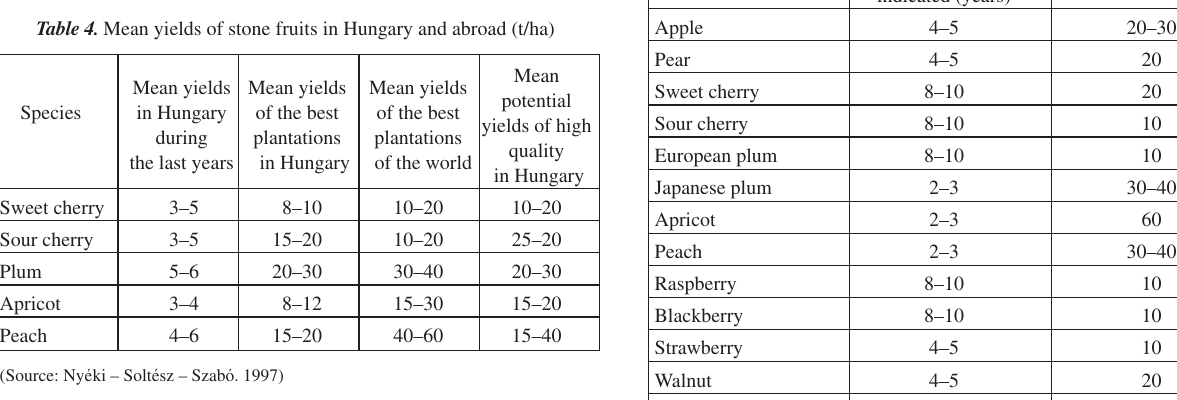
Table 5. Frequency and maximum rates of losses of yield due to winter- and spring frosts in fruit plantations under Hungarian conditions Significant* damages of yield are